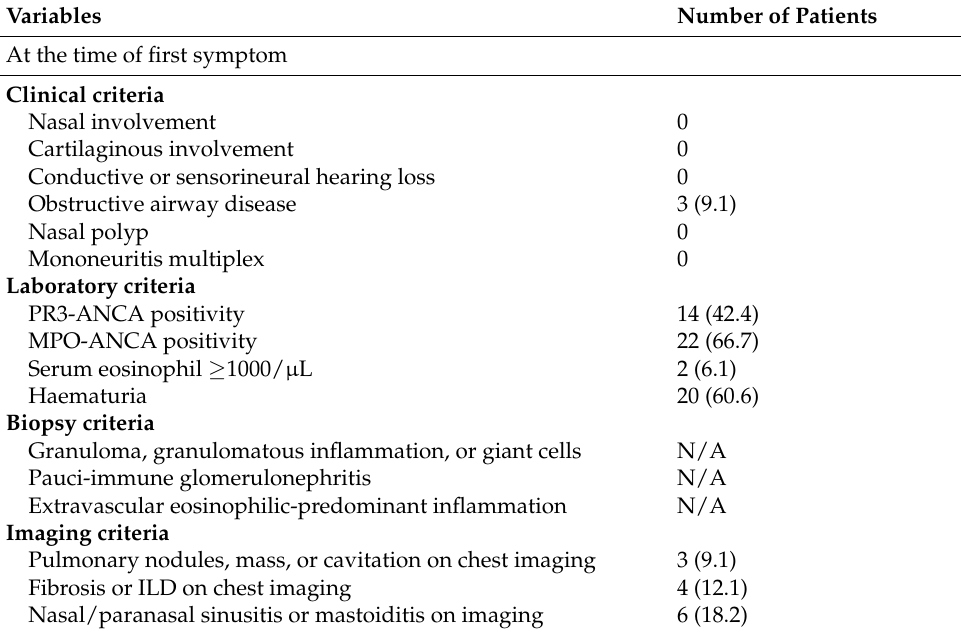
Table 2. Application of 2022 ACR/EULAR classification criteria for GPA, MPA, or EGPA to patients infected by SARS-CoV-2 with positive detection of ANCAs ( n = 33).